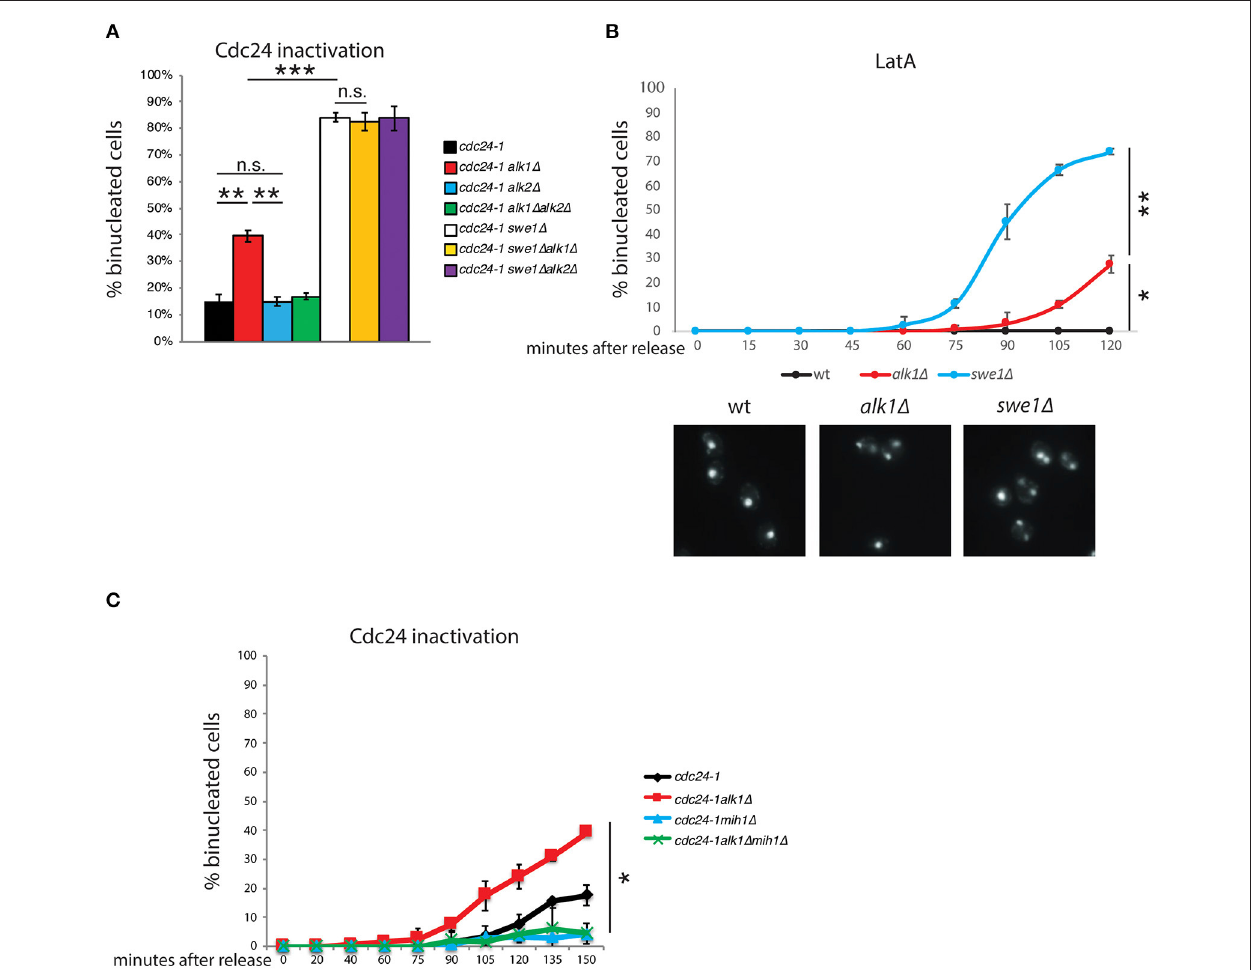
FIGURE 2 | Alk1 regulates cell cycle progression through Mih1. Cells of the indicated strains were arrested in G1 at 25 ◦ C and held at 37 ◦ C for further 45’ before being released at 37 ◦ C. After 2h samples were taken and nuclear segregation was evaluated by fluorescence microscopy (A) For wt, alk1 1 , alk2 1 and alk1 1 alk2 1 , the mean value was calculated on data from experiment in Figure 1C combined with new biological replicates performed together with the other indicated strains. (B) Cells of the indicated strains were synchronized in G1 and treated with LatA. Following release, samples were taken to monitor nuclear division by fluorescence microscopy. Representative images at the 120’ time point are shown (C) Cells were treated as in A, taking samples at the indicated time points to monitor nuclear segregation or cell-cycle progression ( Supplementary Figure 2 ). Error bars represent standard deviation, statistical significance was measured by T -test, ns: not significant, * p < 0.05, ** p < 0.01, *** p <